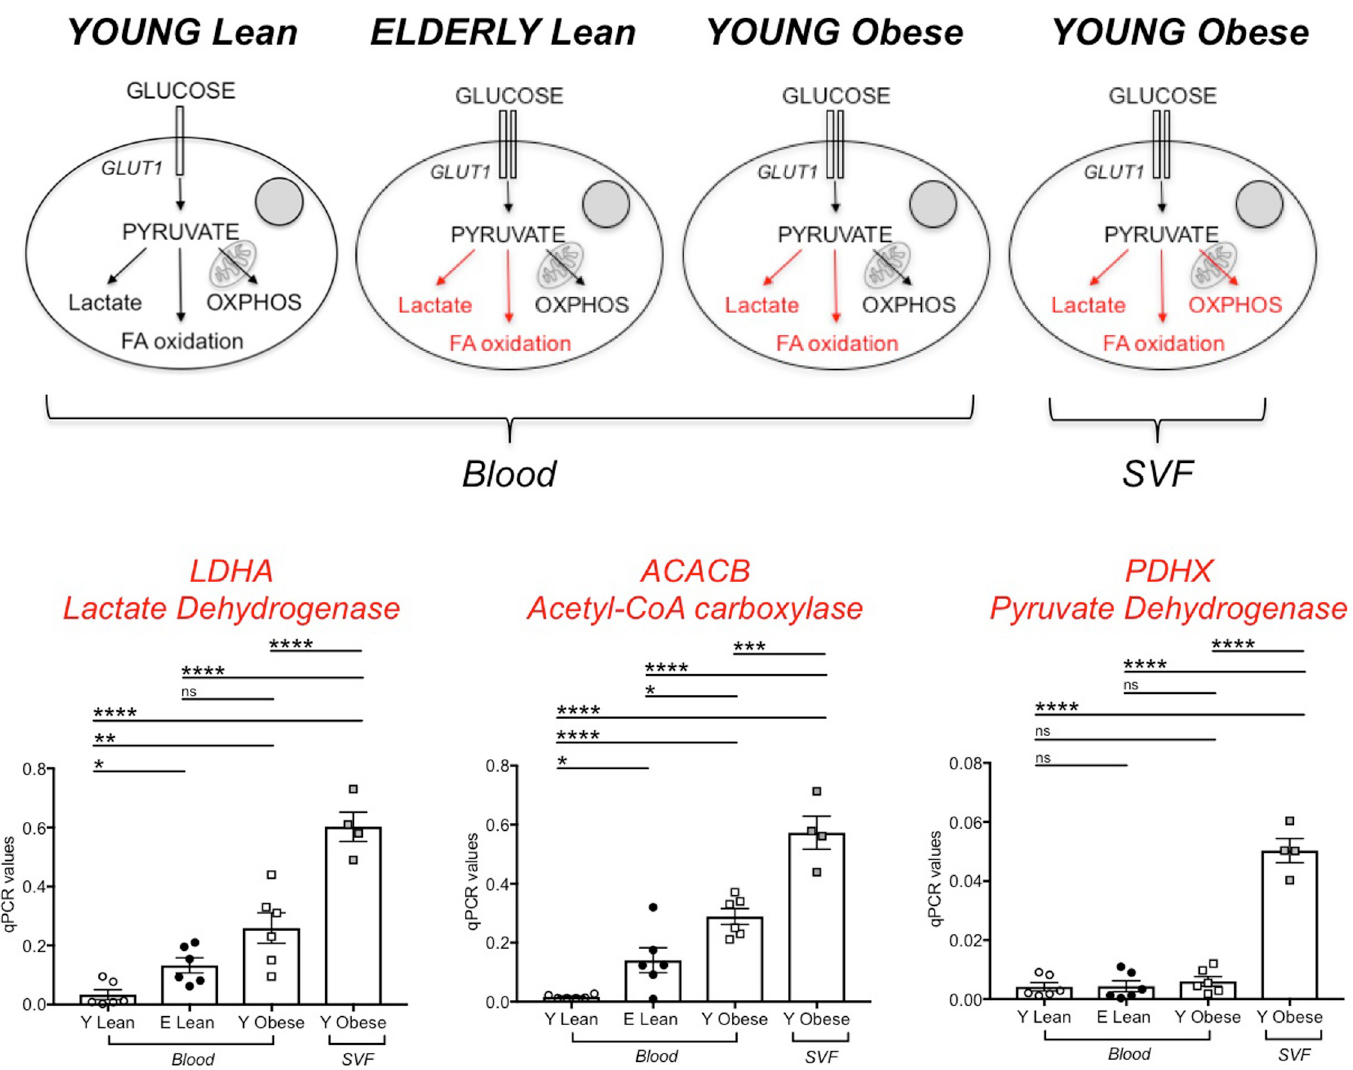
Fig 7. Effects of aging and obesity on glycolytic measures in DN B cells. PBMC and SVF were obtained as indicated previously. Top . A model to explain the different glycolytic pathways in the different groups is shown. In red are indicated activated pathways. Bottom . Results show qPCR values (2 - ΔΔ Ct ) of LDHA, ACACB and PDHX. Mean comparisons between groups were performed by one-way ANOVA. � p < 0.05, �� p < 0.01, ��� p < 0.001, ���� p < 0.0001, ns: not significant.